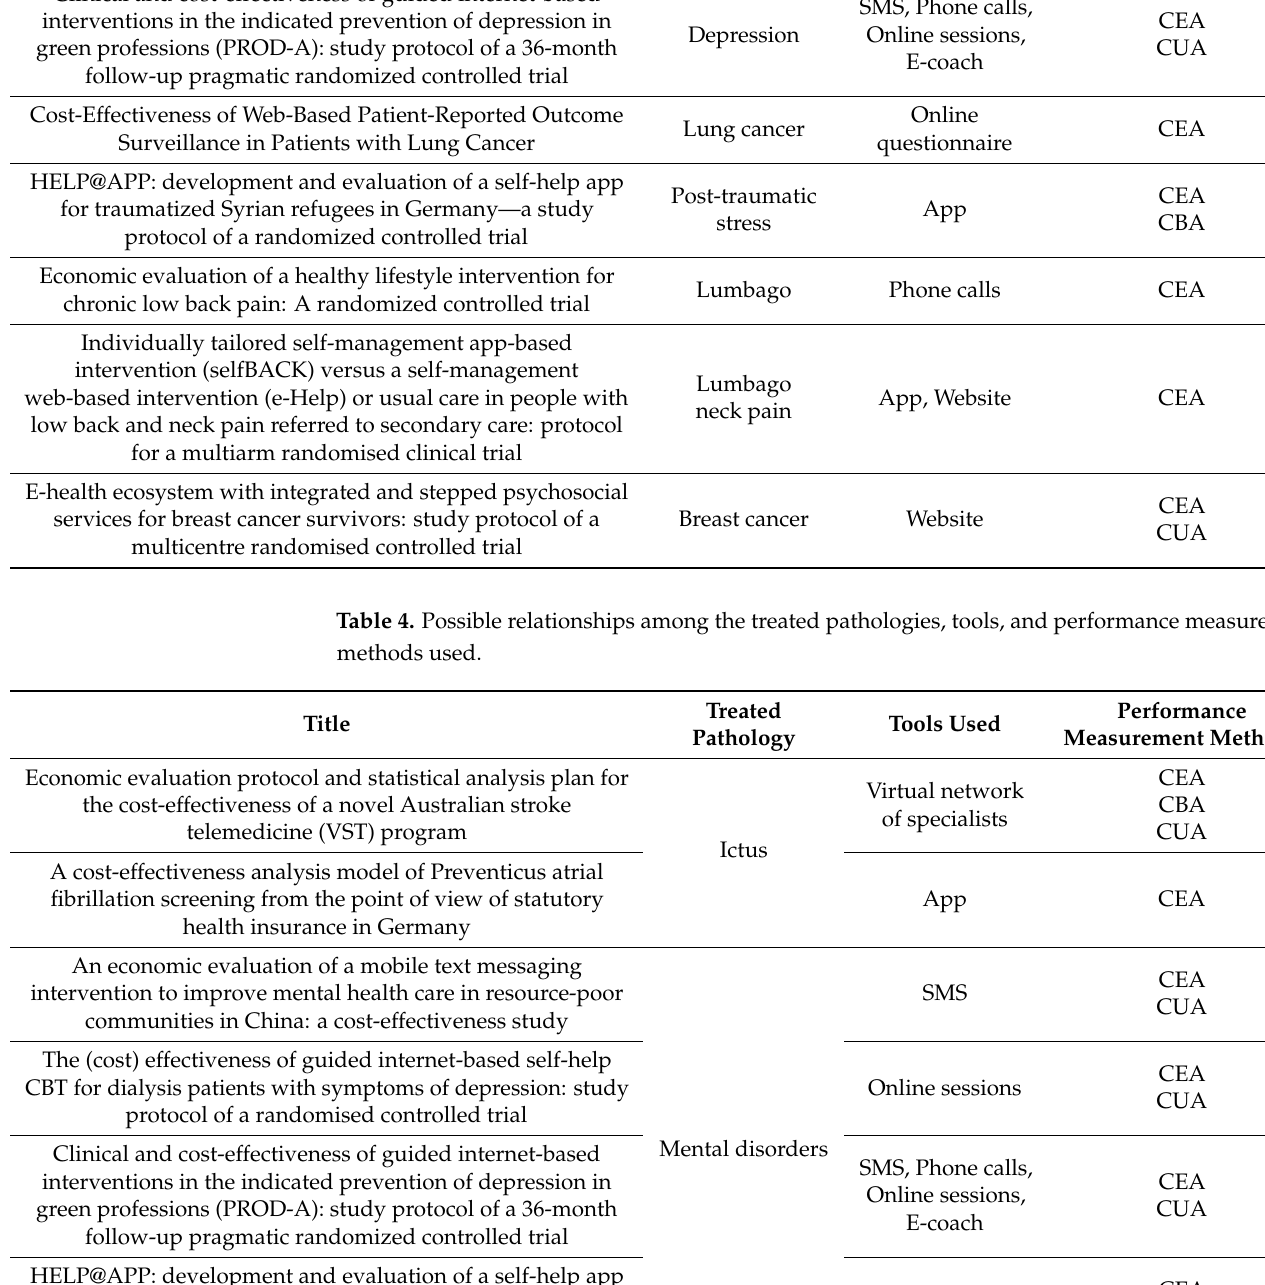
Performance Measurement Methods